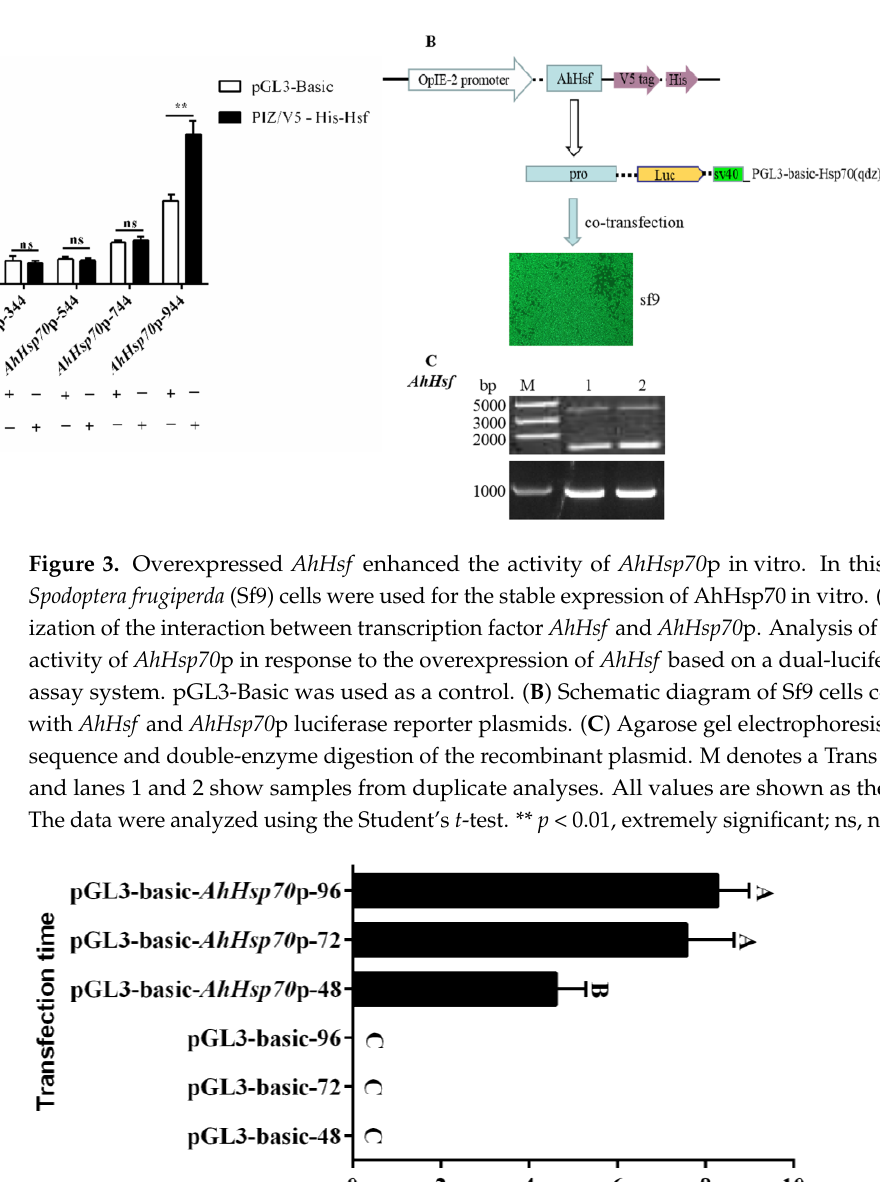
Figure 4 . Expression analysis of AhHsp70 gene at 48, 72, and 96 h after transfection in Spodoptera frugiperda ( Sf9) cells. Relative mRNA levels were determined using the 2 −ΔΔCt method and normal- ized to those of the β -actin . The figure shows data on the relative AhHsp70 gene expression levels